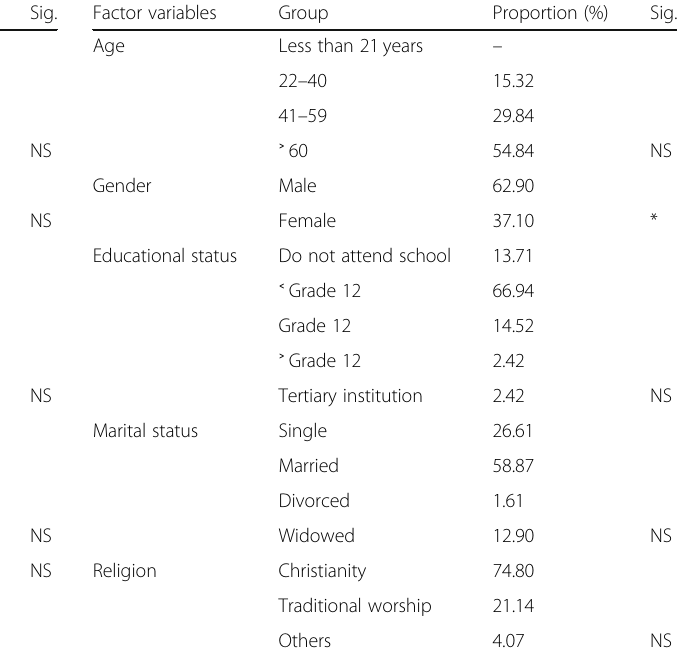
Table 6 Chi-square test result of factors that influence